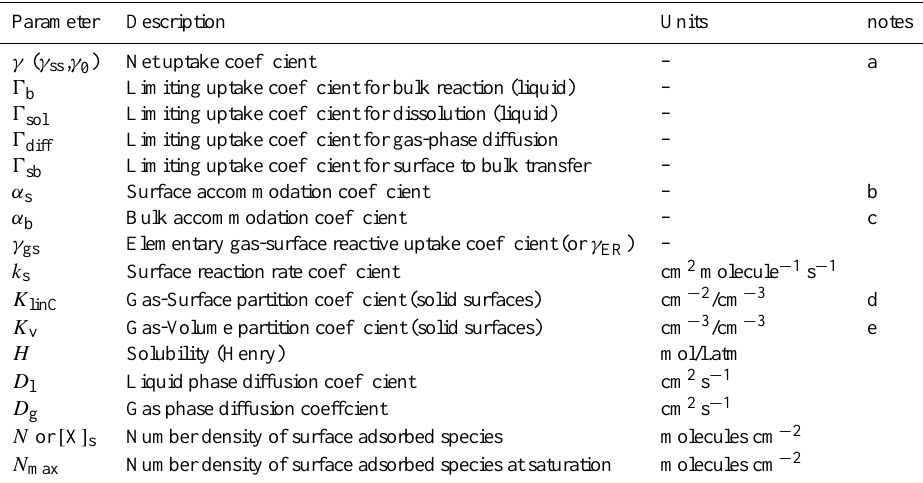
Table 1. Parameters used to describe heterogeneous reactions.